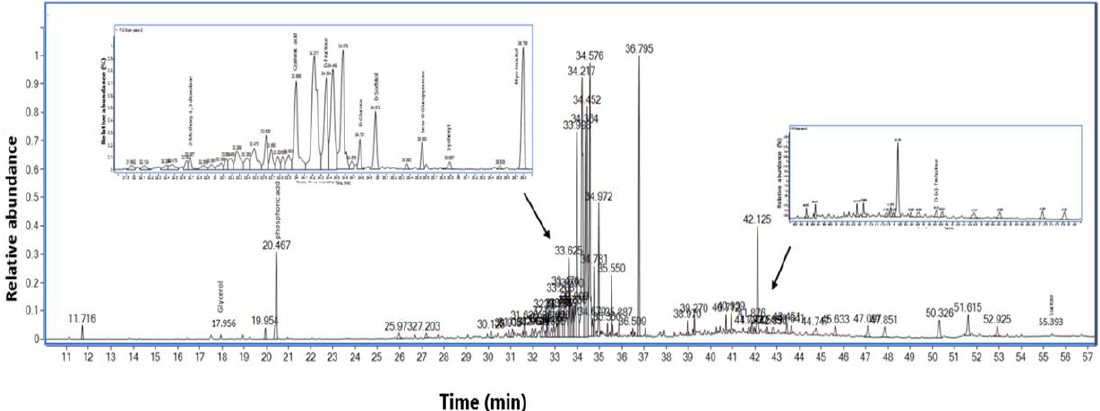
Figure 6. GC-MS chromatogram of the HTE. Major peaks are labeled with the compounds identified. Zoom; region of the elution of some compounds.